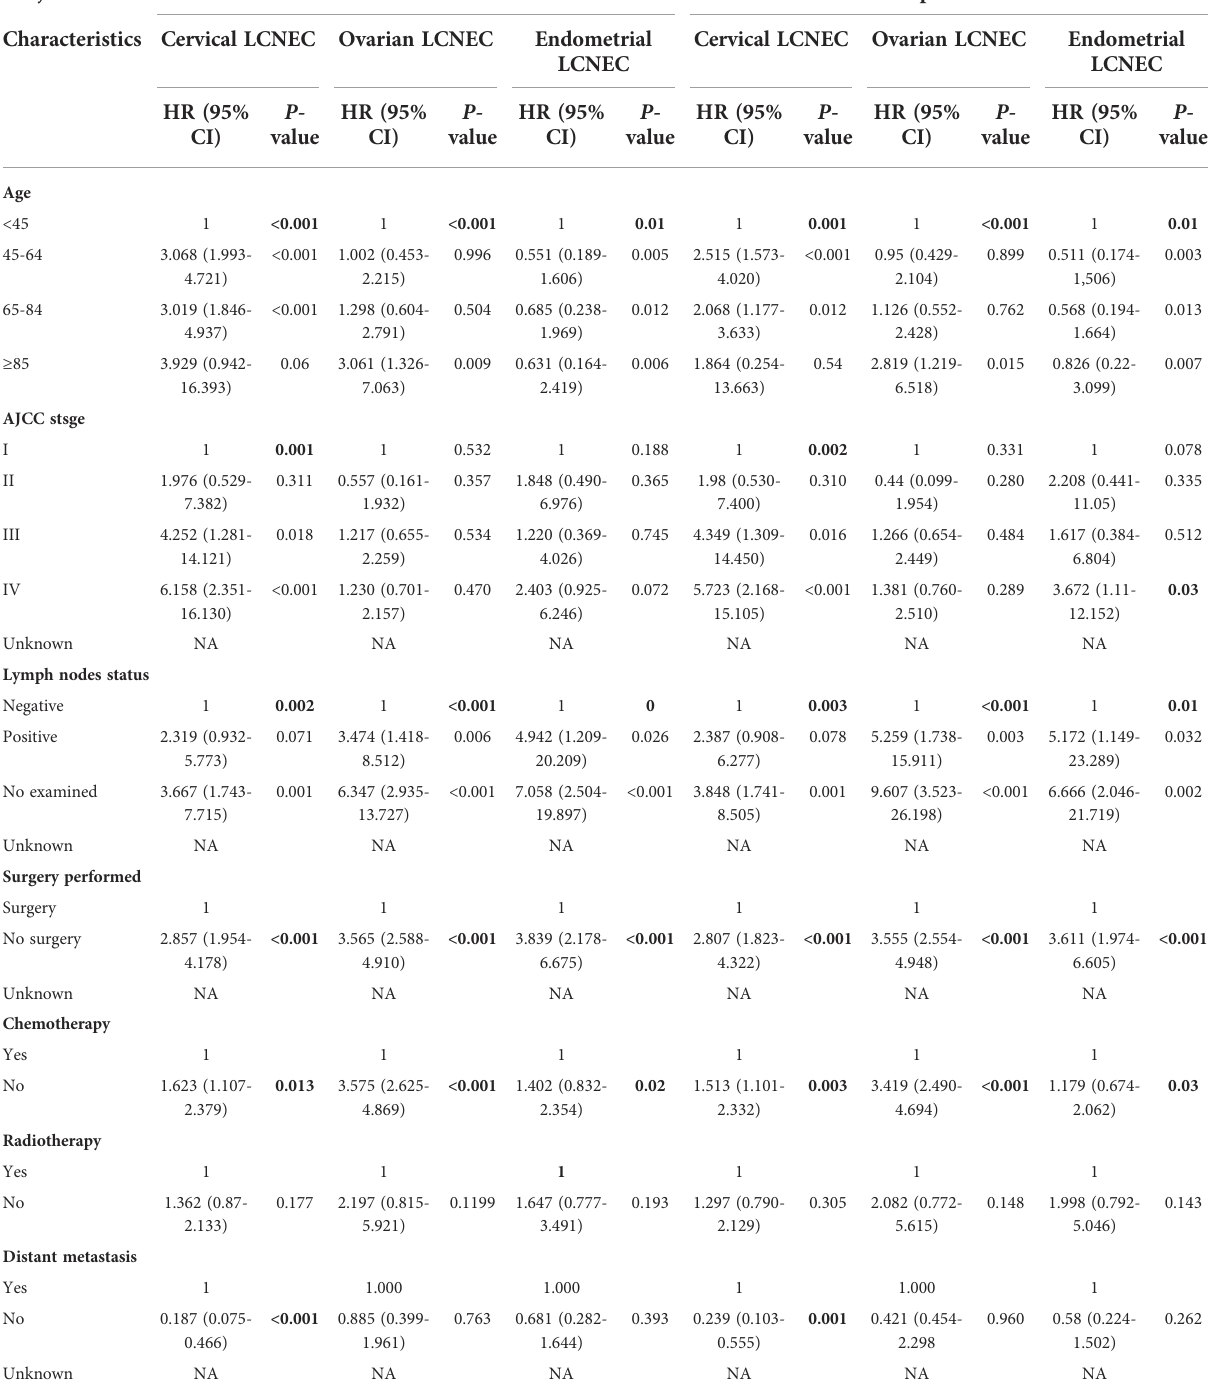
TABLE 2 Univariate-Prognostic factors for gynecologic large-cell neuroendocrine carcinoma